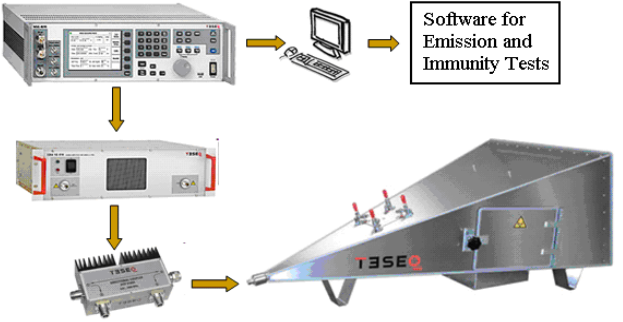
Figure 18. Schematic with the equipment used for measurement in GTEM cell 750 [36].